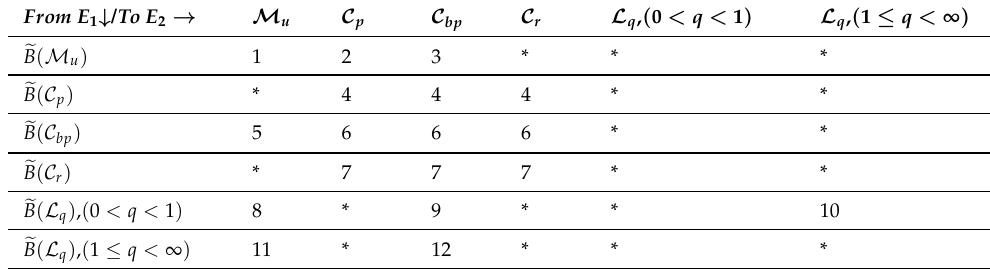
Table 4. 4D matrix classes ( (cid:101) B ( E 1 ) ; E 2 ) , where E 1 , E 2 ∈ {M u , C p , C bp , C r , L q }